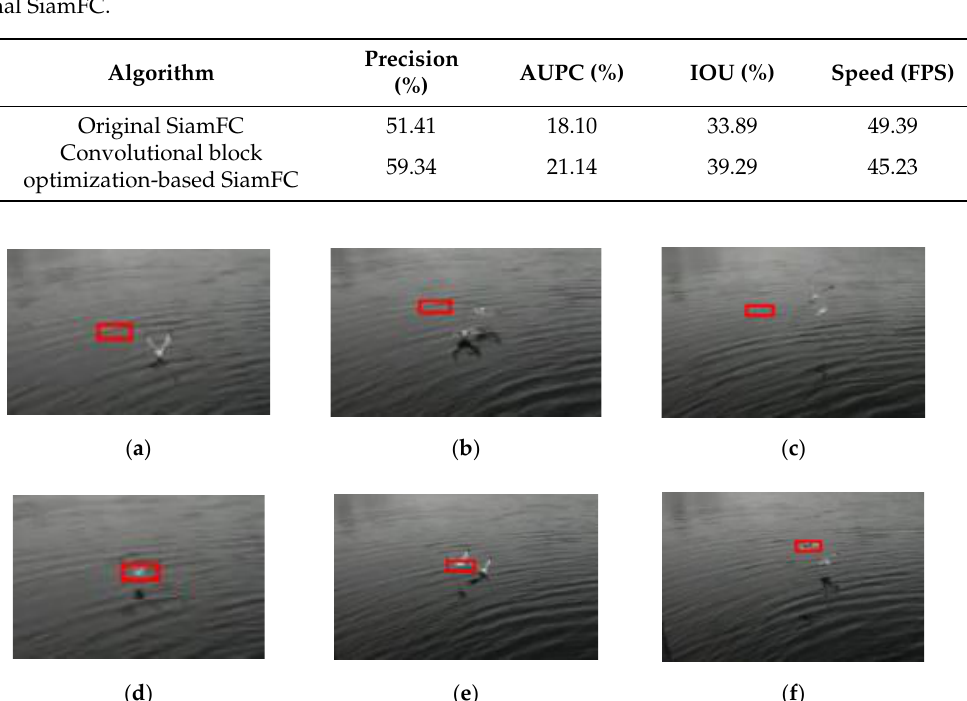
Figure 10. Comparison of original SiamFC and our convolutional block optimization-based SiamFC in scene “Birds 1”: ( a – c ) Snapshots from original SiamFC (Precision: 7.67, AUPC: 3.33, IOU: 5.55, Speed